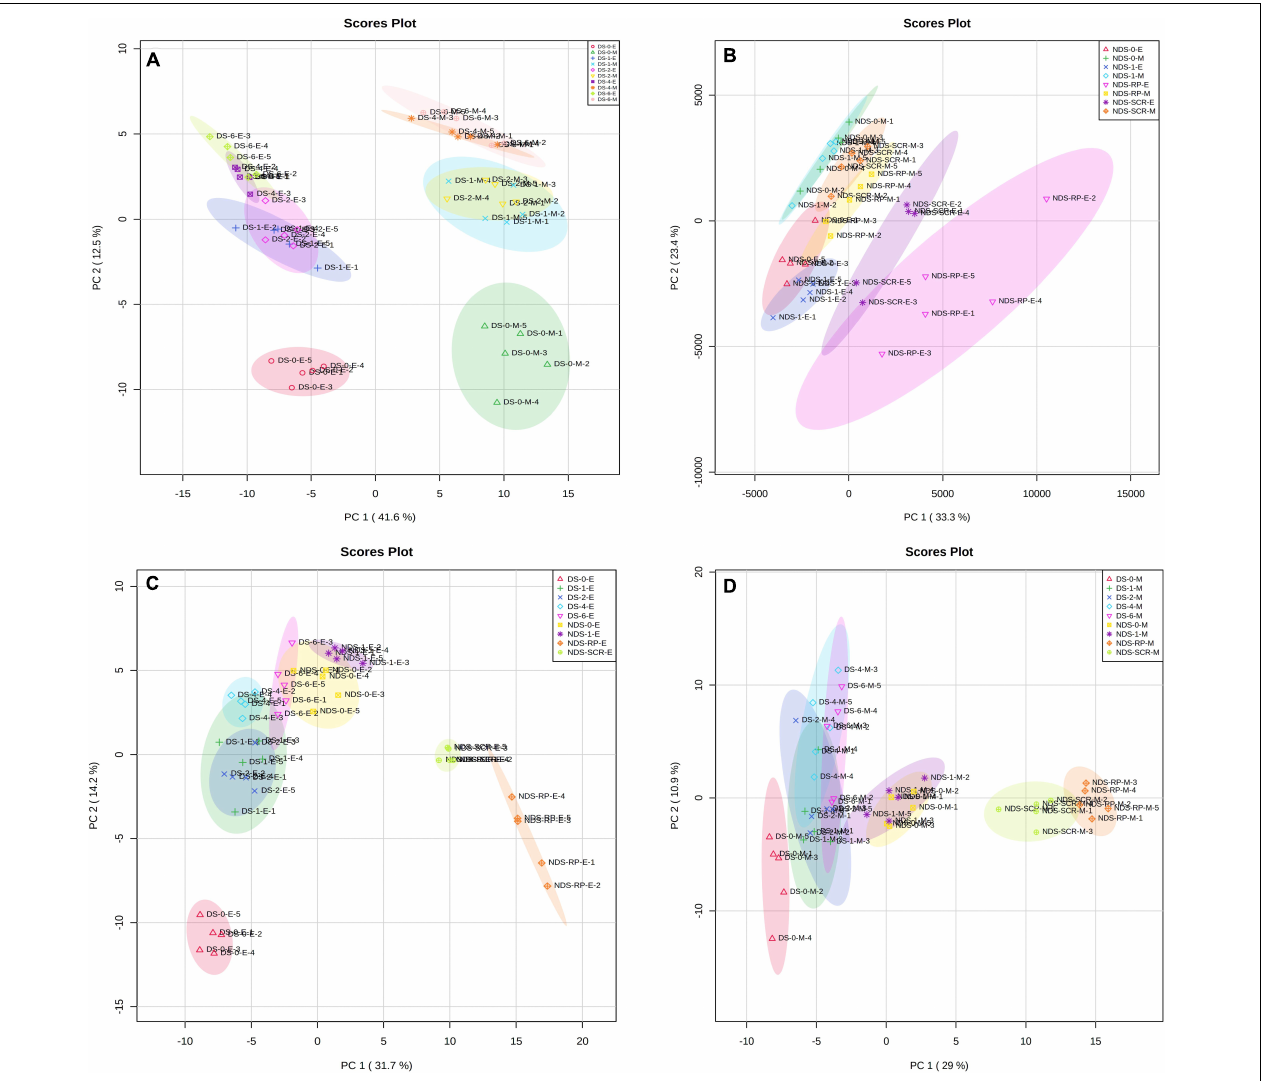
FIGURE 1 | Principal components analysis (PCA) of metabolite profiles in (A) the embryos (E) and megagametophytes (M) of primary physiological dormant seeds (DS) sampled at 0 week of incubation (DS-0-E and DS-0-M), 1 week of incubation (DS-1-E and DS-1-M), 2 weeks of incubation (DS-2-E and DS-2-M), 4 weeks of incubation (DS-4-E and DS-4-M), and 6 weeks of incubation (DS-6-E and DS-6-M), (B) the embryos and megagametophytes of non-primary physiological dormant seeds (NDS) sampled at 0 week of incubation (NDS-0-E and NDS-0-M), 1 week of incubation (NDS-1-E and NDS-1-M), seed coat rupture stage (NDS-SCR-E and NDS-SCR-M), and radicle protrusion stage (NDS-RP-E and NDS-RP-M), (C) the embryos of DS and NDS, and (D) the megagametophytes of DS and